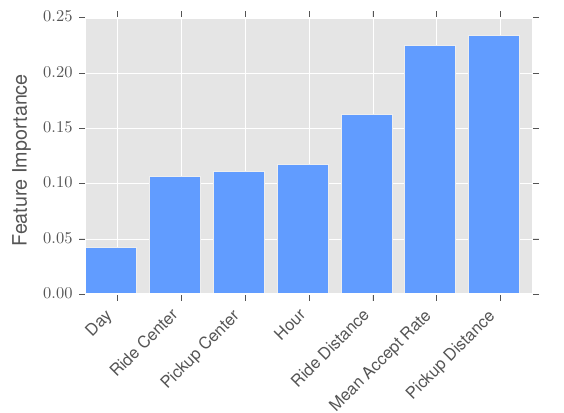
Figure 5. Feature ranking of Liftago data. The bars show the feature importance of driversbiddingobtainedusing the random decisionforestensemblealgorithmbased on200 trees. The most important features are those approximatingride orderdistances (Pickup Distance and Ride Distance) and Mean Accept Rate based on per-driveraggregated historicaldata.